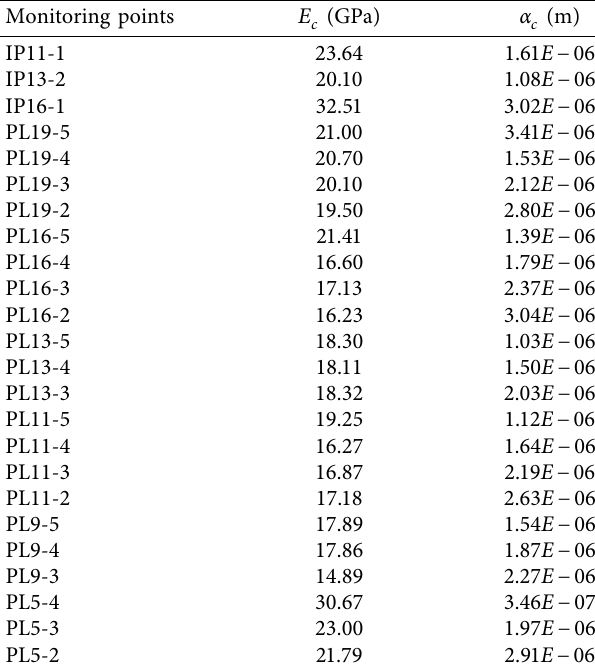
Table 4: The actual elastic modulus E linear expansion α c at each monitoring